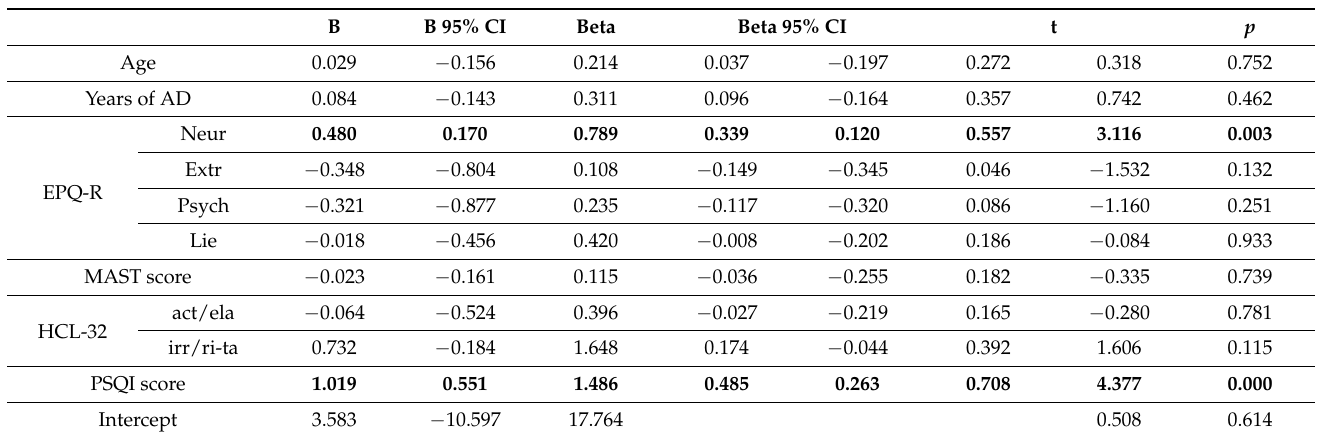
Table 5. Model 1.